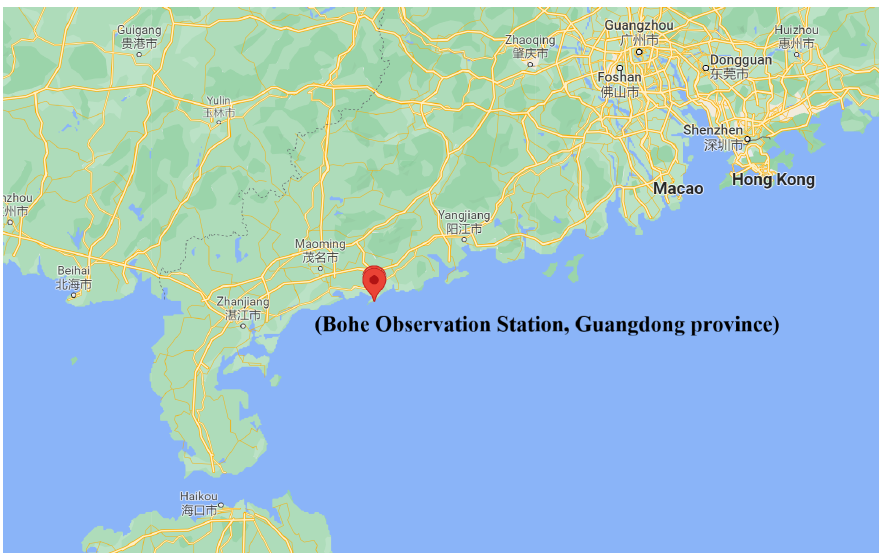
Figure 5. Google map of Bohe observation station with a longitude of 111.32° and a latitude of